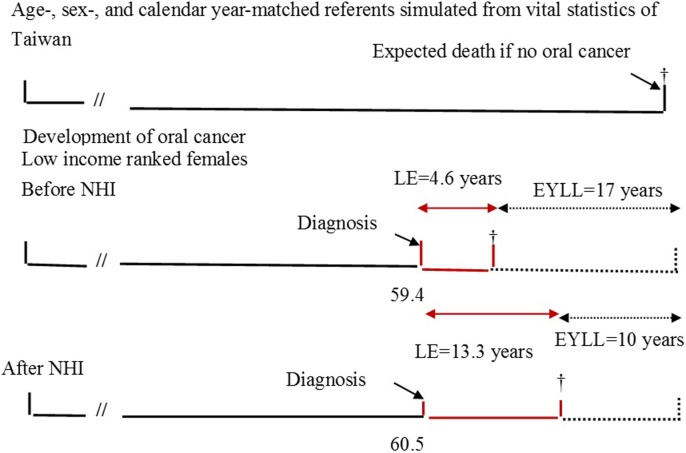
Before NHI: A case of oral squamous cell carcinoma (OSCC) for low income ranked female is on average diagnosed at age of 59.4 (Table 1), while that after National Health Insurance (NHI) is at age of 60.5.The gain in life expectancy (LE) between before and after NHI would be 13.3–4.6 = 8.7 years. However, if we take two different ages and calendar periods of diagnosis into account by comparing the difference in expected years of life lost (EYLLs) of the above two systems, the potential gain would be 17–10 = 7 years. † indicates mortality.